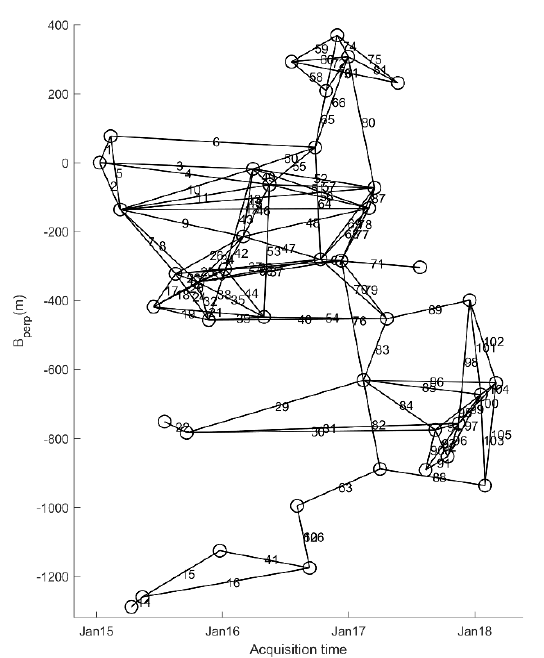
Figure 1. The spatial-temporal baseline distribution of the 106 interferograms